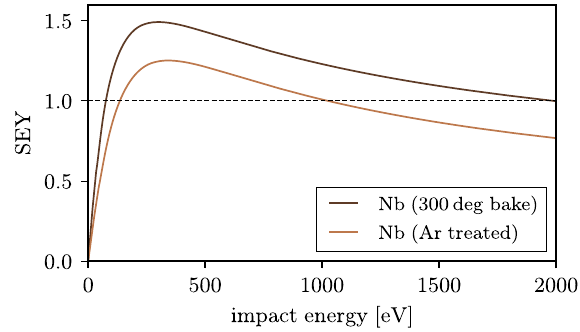
FIG. 13. The partition of the cavity surface to provide local initial field